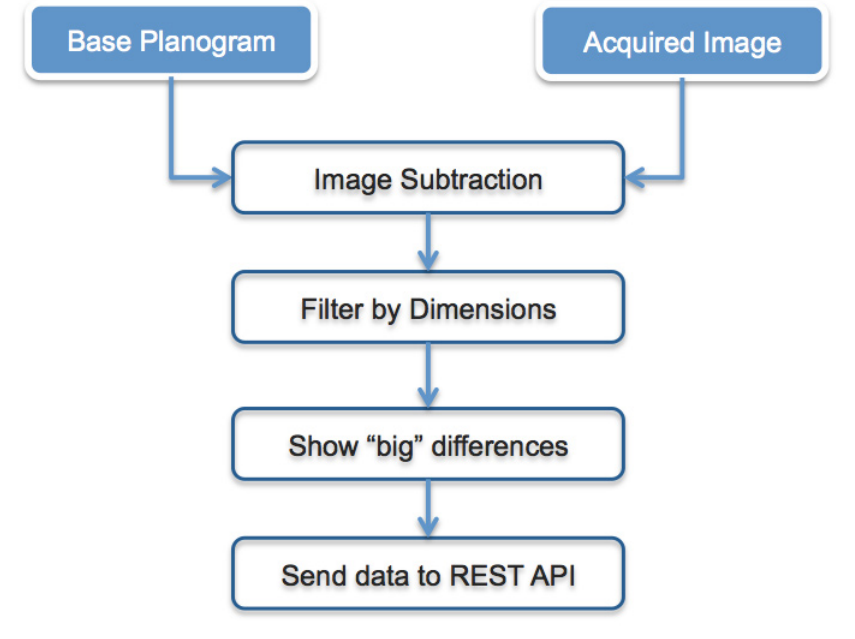
Figure 6. Representation of the implemented image processing